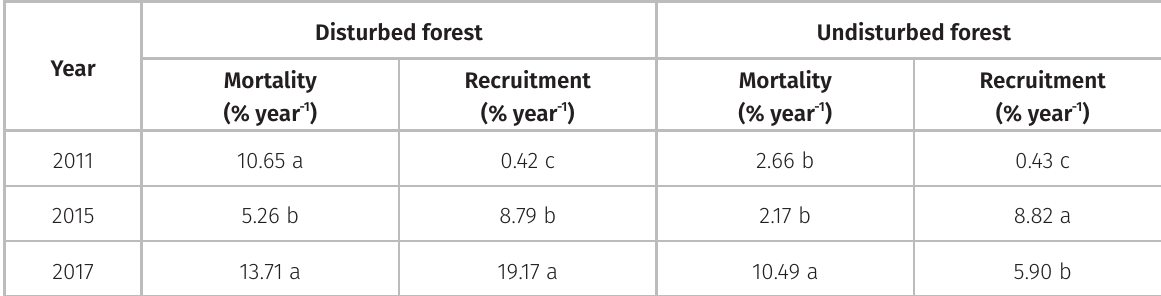
Different lower-case letters indicate statistical difference, the Tukey test was performed at 0.05 level of